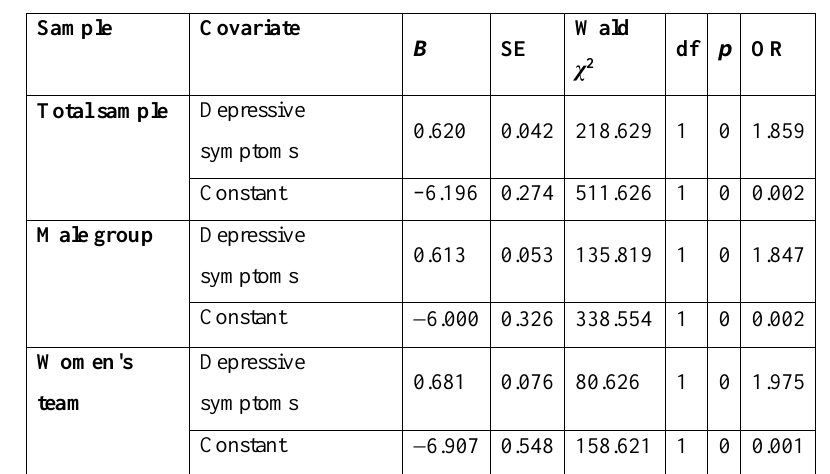
Table 2 Binary logistic regression early warning of undergraduates’ depressive symptoms